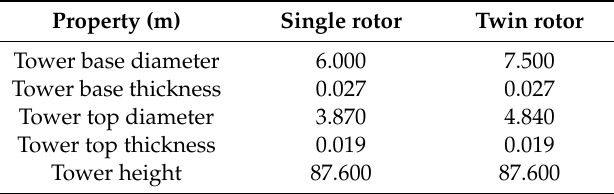
Figure 16. Sketch of the twin-rotor configuration. Table 3. Tower geometry.